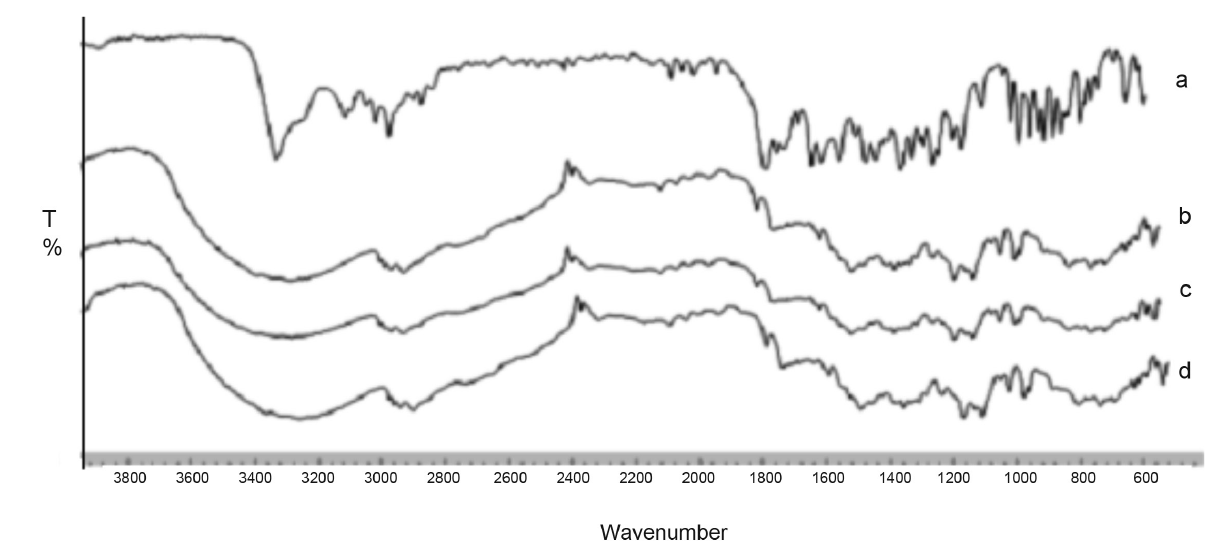
FIGURE 12 - I.R of Nifedipine (a), DO II (b), CRP II (c) and CCS II